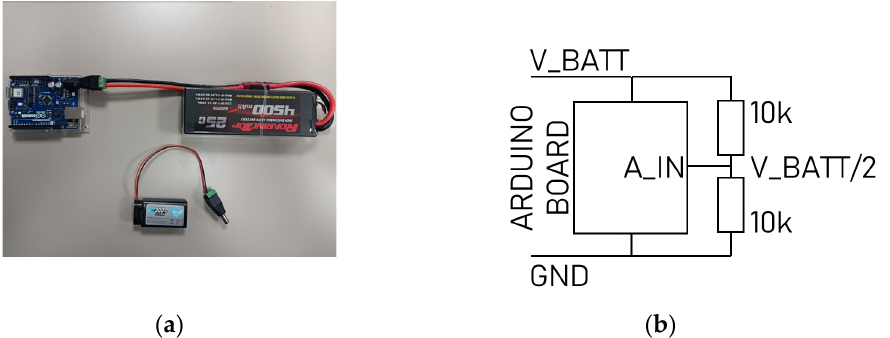
Figure 11. ( a ) Arduino WiFi R2 board in blue connected to a Lipo battery. Above, the NiMH battery; ( b ) electrical circuit for monitoring the battery voltage. Equipment: NiMH battery charger, 9 V NiMH battery 300 mAh, LiPo charger, LiPo 2S 4500 mAh battery.